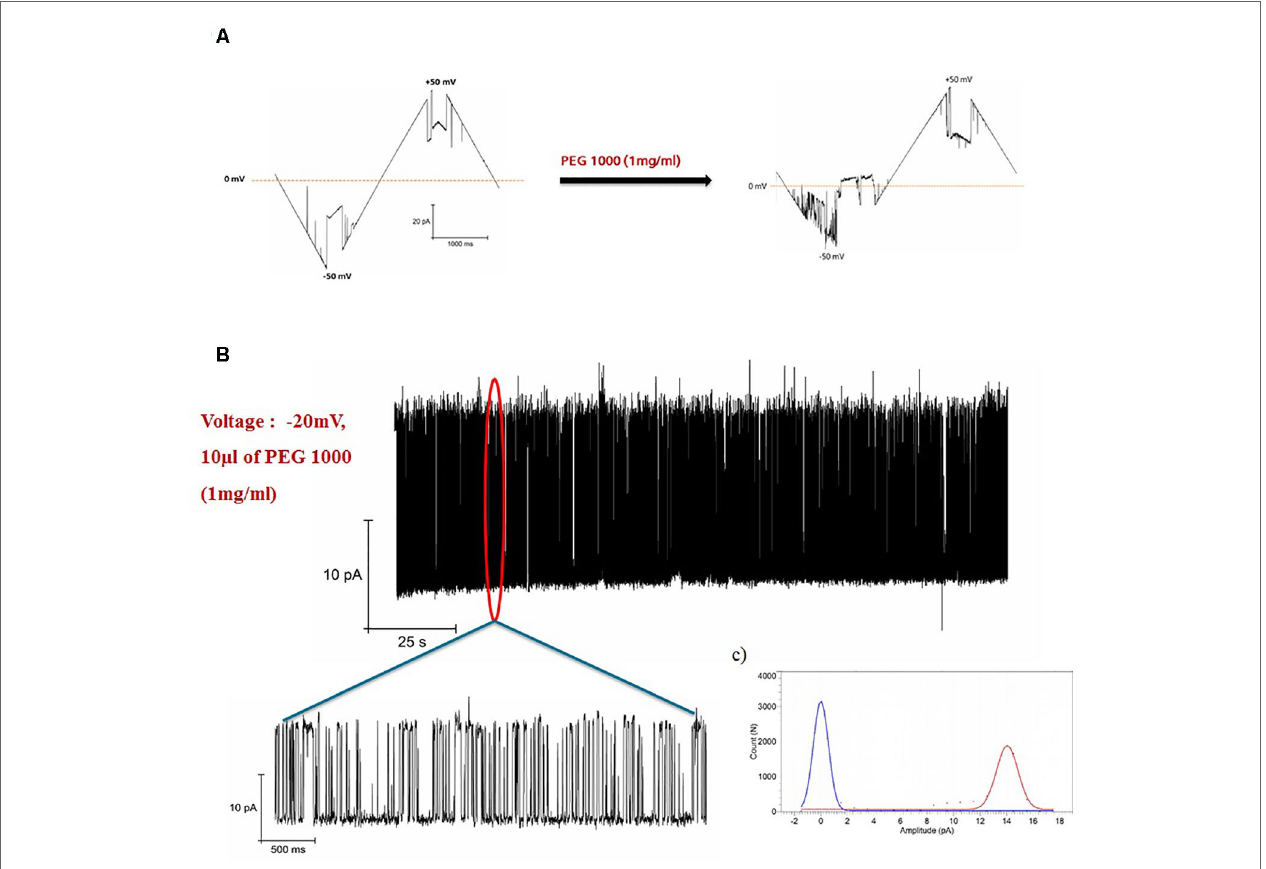
(C) Histogram of the current blockades showing the pore opening and closing events caused by the PEG1000 molecules. All measurements were performed in the presence of 10 mM HEPES, 150 mM CaCl2, pH